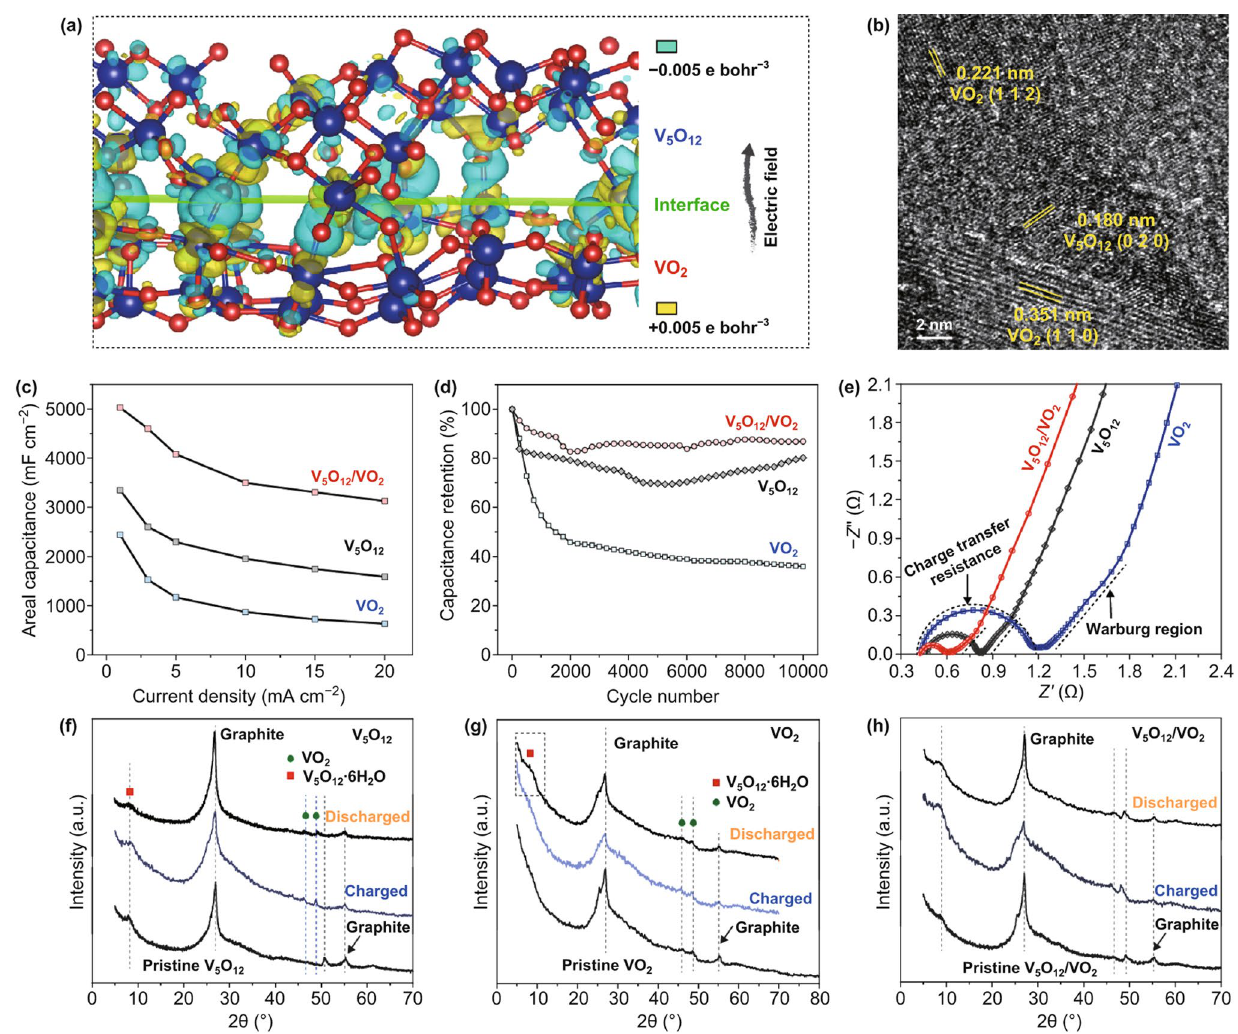
Fig. 22 a Charge density distribution along the interface of V 5 O 12 /VO 2 . b TEM image of V 5 O 12 /VO 2 junction. c Areal capacitance of V 5 O 12 / VO 2 , V 5 O 12 , and VO 2 as a function of current density. d Cycling stability of V 5 O 12 /VO 2 , V 5 O 12 , and VO 2 electrodes in 3 M LiCl aqueous elec‑ trolyte. e Nyquist plots of V 5 O 12 /VO 2 , V 5 O 12 , and VO 2 . f – h Ex situ XRD patterns of f V 5 O 12 , e VO 2 and h V 5 O 12 /VO 2 without charging (pris‑ tine), charged (− 1 V), and discharged (0 V). Reproduced from Ref. [34] with